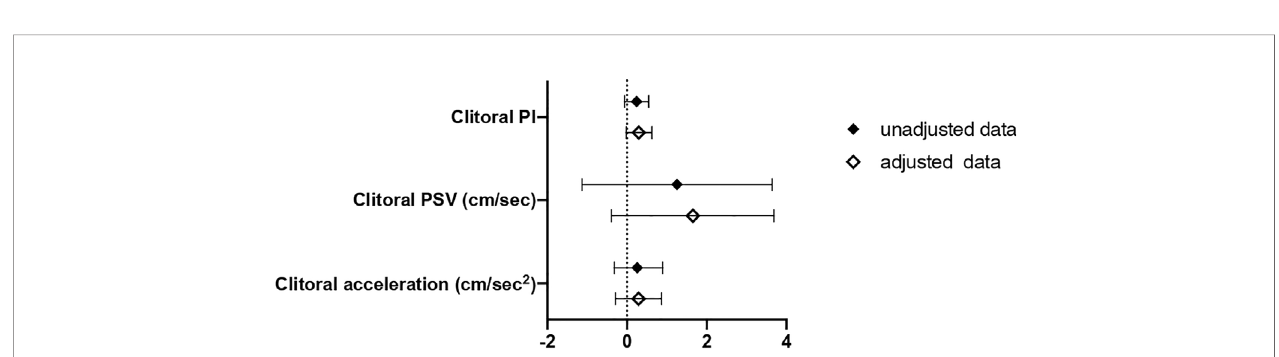
menopausal status and years from menopause. PI, pulsatility index; PSV, peak systolic velocity; ACC, basal acceleration.